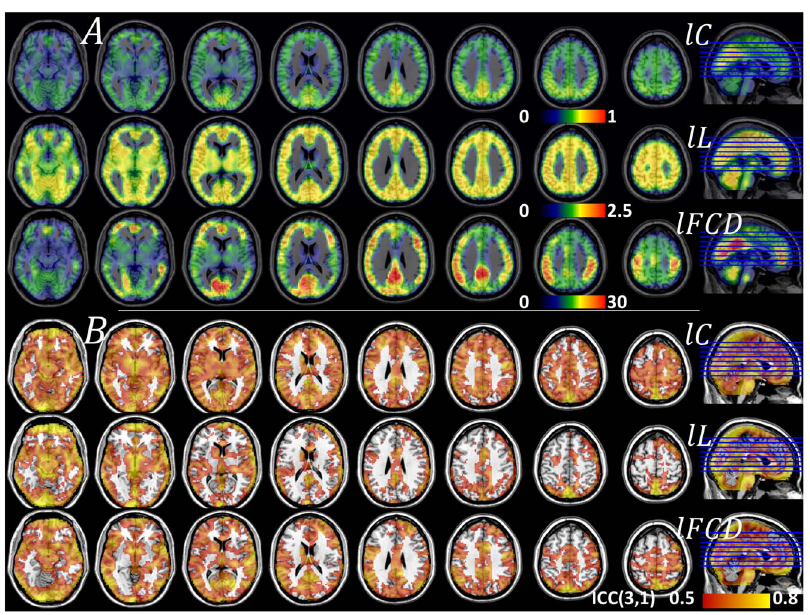
Figure 2. Regional measures of absolute graph theory properties. (A) Average strength of local clustering, lC , characteristic path length, lL , and functional connectivity density (degree), l FCD, of the networks functionally connected to each imaging voxel, superimposed on axial views of the human brain. (B) Maps of two-way mixed single measures intraclass correlation, ICC(3,1) demonstrating the good reliability (ICC . 0.5) of lC , lL and l FCD across sessions and method thresholds. Sample: 3 resting-state sessions from 40 healthy children (WashU dataset), correlation thresholds: R T1 =